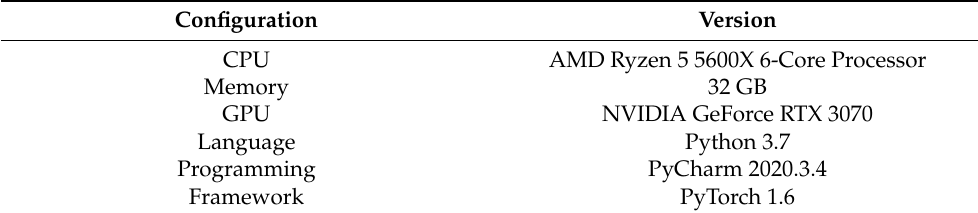
Table 3. The hardware and software configurations for the